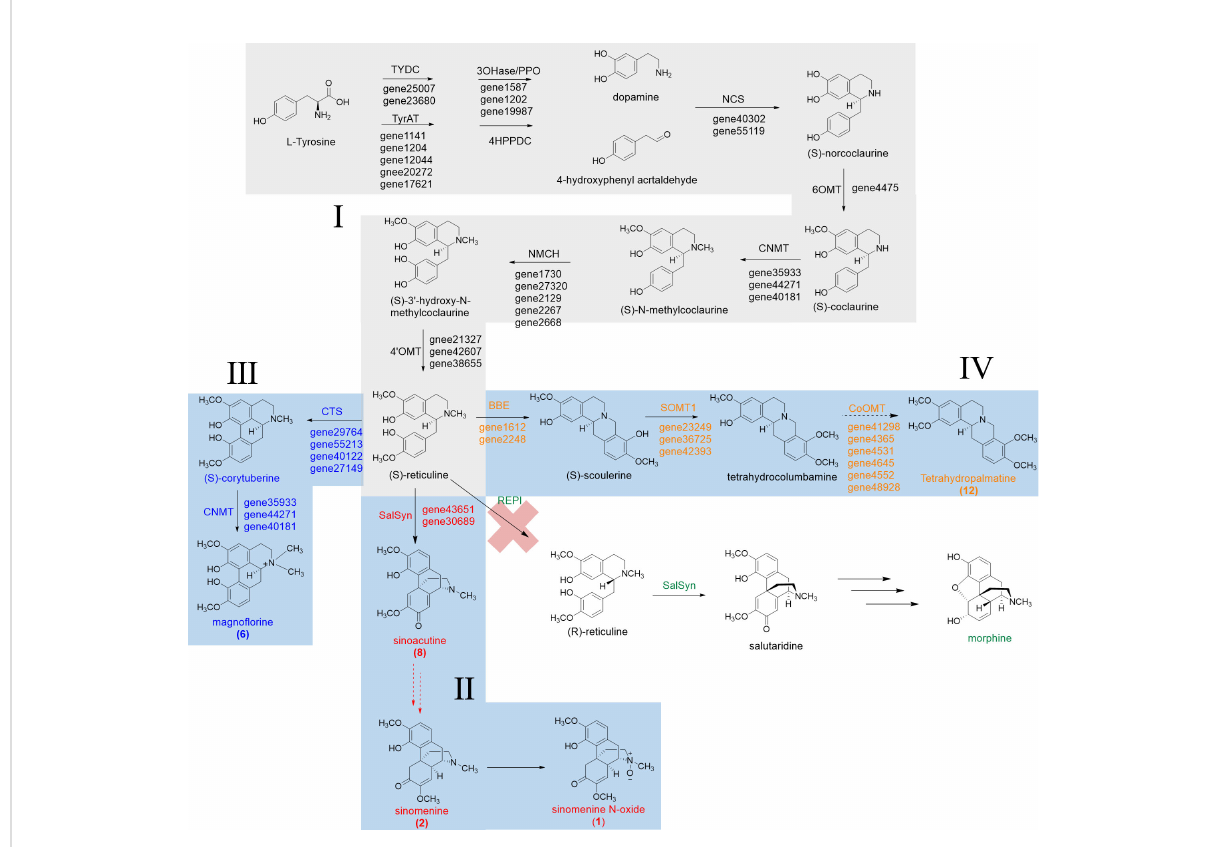
FIGURE 7 Proposed biosynthetic pathways for sinomenine, magno fl orine, and tetrahydropalmatine in S. acutum